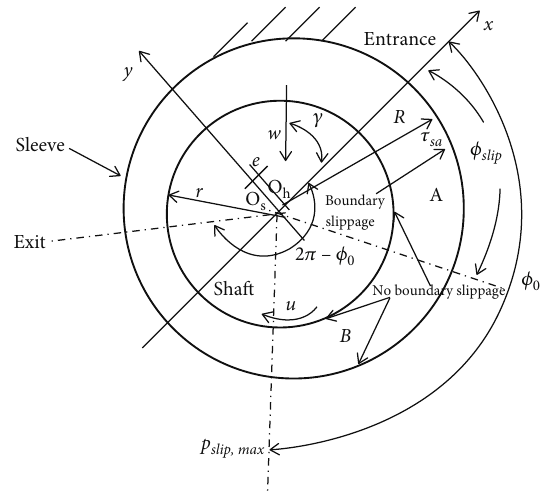
Figure 2: Energy-conserved hydrodynamic journal bearing with the wall slippage on the stationary sleeve surface in the inlet zone